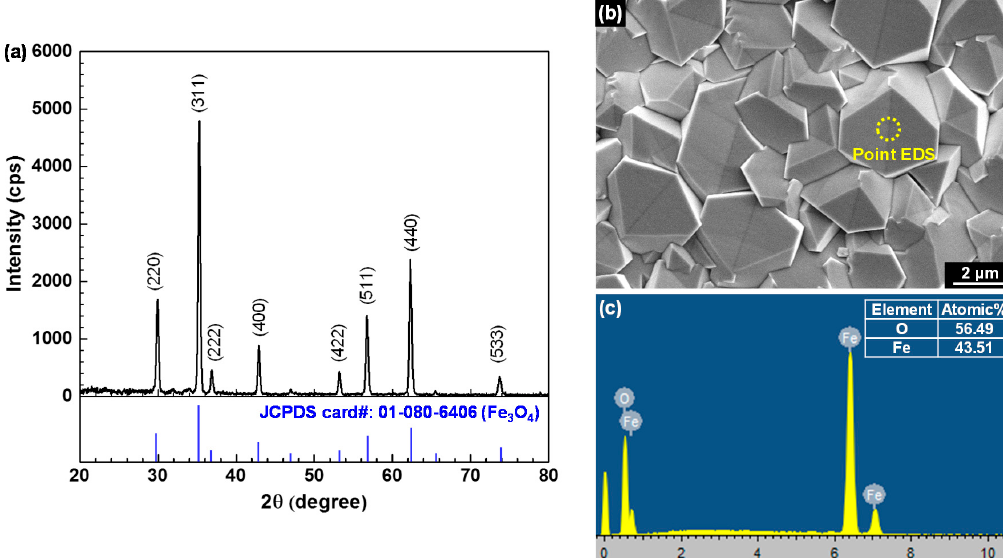
Figure 3. ( a ) X-ray diffraction (XRD) patterns, ( b ) surface scanning electron microscope (SEM) image, and ( c ) point X-ray spectroscopy (EDS) analysis of the electrodeposited magnetite